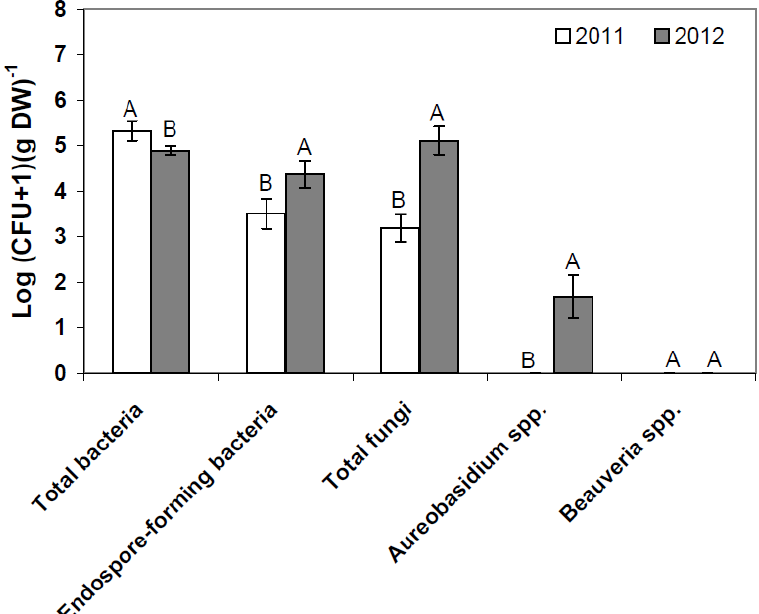
Figure 1. Resident phyllosphere microbiome of flowering strawberries (BBCH 60) in 2011 and 2012 as determined by plate counts (pooled data, each N = 36). Error bars represent SEM values. Columns marked with the same letters are not significantly different within each microbial group ( α =